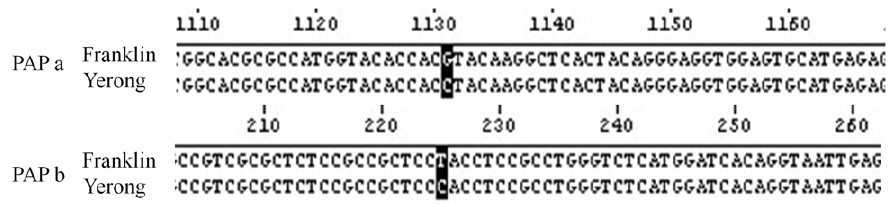
Figure 4. Single nucleotide polymorphism (SNP) of HvPAPa and HvPAPb used for SNP marker design between Yerong and Franklin.